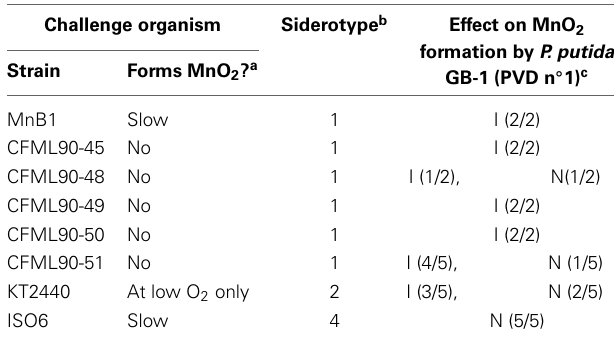
Table 1 | Effect of PVD-producing organisms with various siderotypes on MnO 2 formation by P. putida GB-1 (siderotype n ◦ 1) during co-cultivation